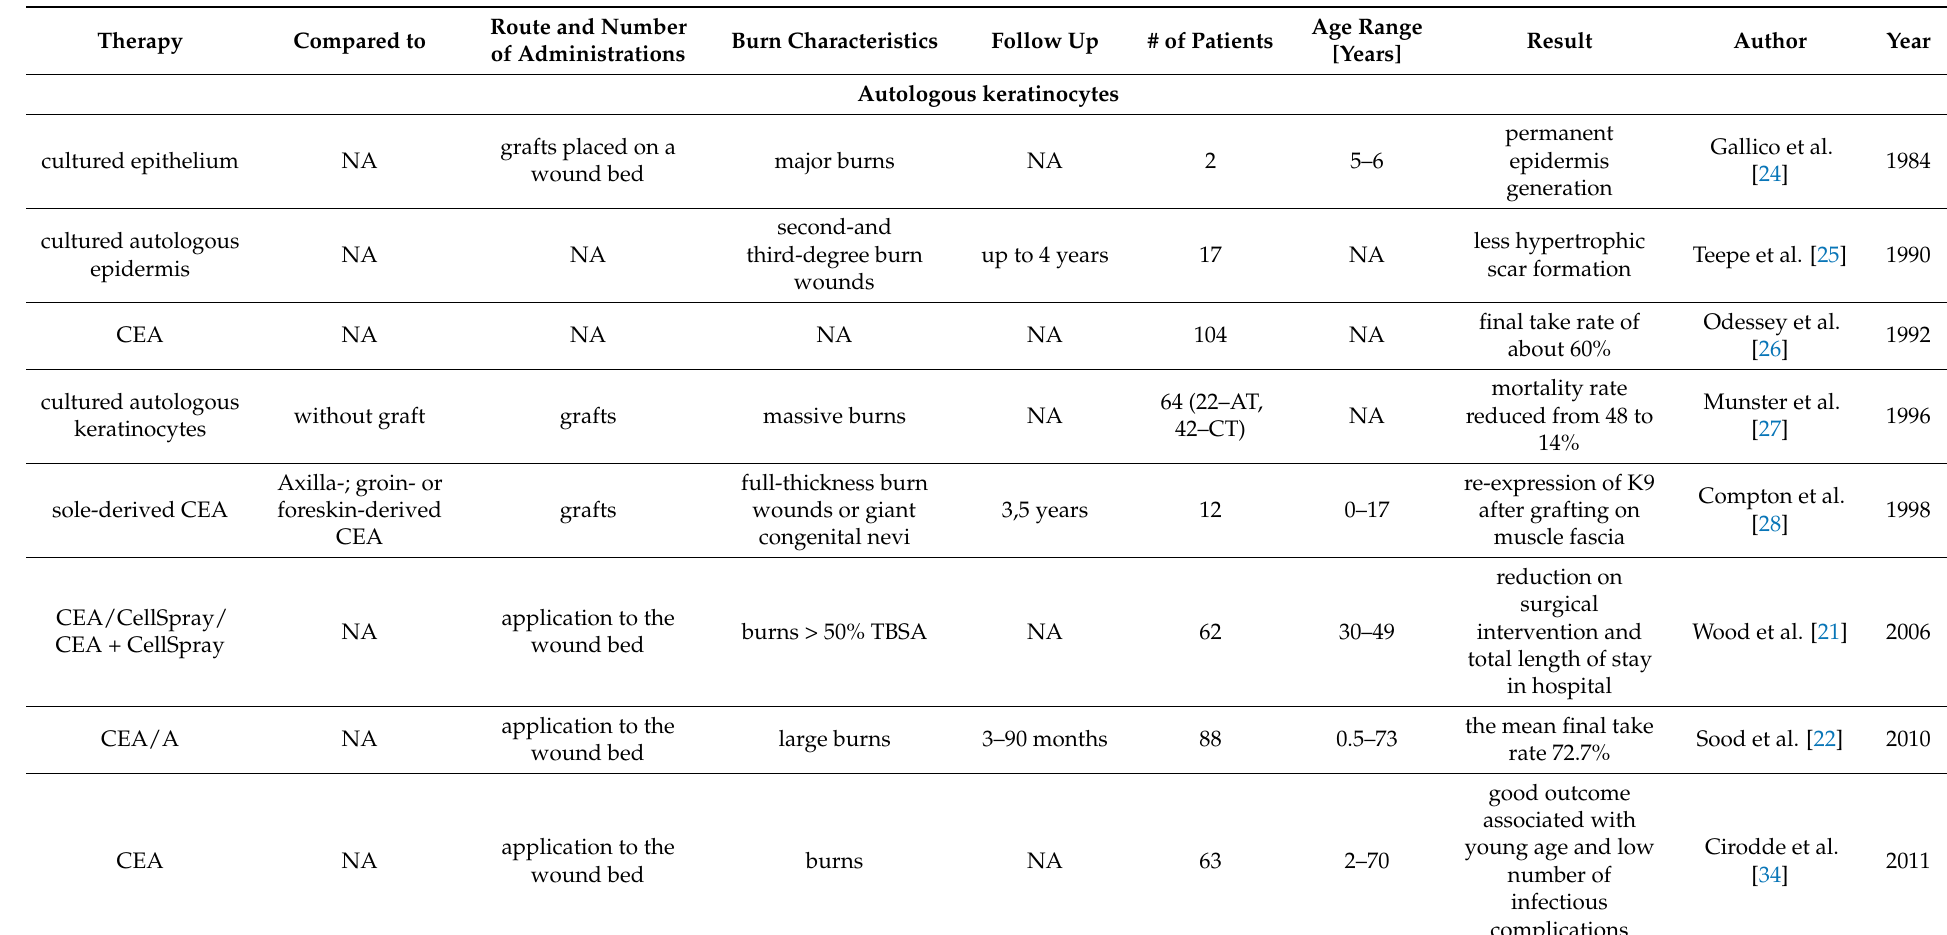
Table 1. Clinical applications of autologous keratinocytes, products based on autologous keratinocyte and autologous engineered skin in burns (NA—not available,